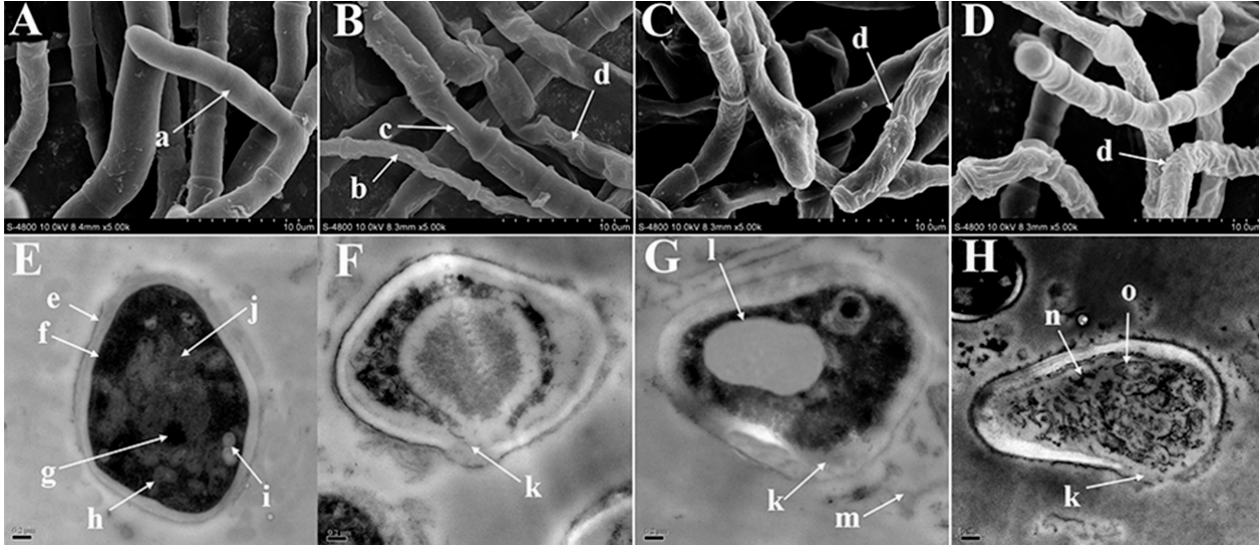
Figure 2. The SEM images of Trichophyton rubrum mycelium and TEM images of T. rubrum conidia treated with specific agents for five days. ( A , E ) control; ( B , F ) terbinafine (MIC); ( C , G ) neral (MIC); ( D , H ) geranial (MIC). (a) distinct branch structure; (b) shriveled mycelium; (c) extreme wrinkles on the surface of mycelium; (d) twisted mycelium surface; (e) cell wall; (f) cell membrane; (g) cell nucleus; (h) mitochondria; (i) vacuole; (j) liposome; (k) broken cell membrane; (l) swollen vacuole; (m) intercellular material; (n) polysaccharide particles; (o) distorted mitochondria. MIC, minimum inhibitory concentration.